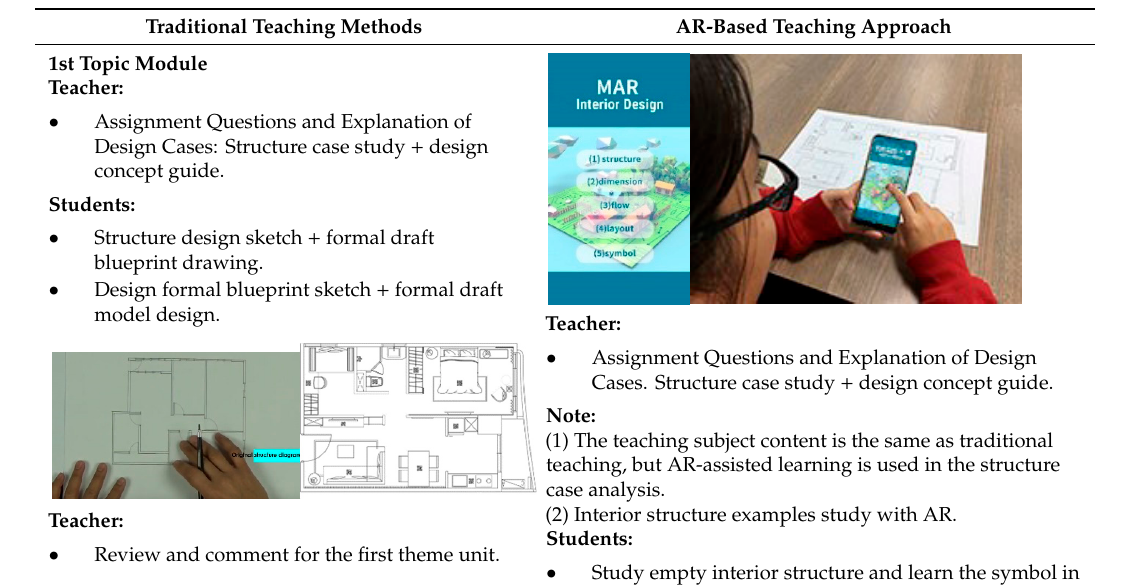
Table 2. Software run-through and comparison between experimental AR-based and traditional teaching.